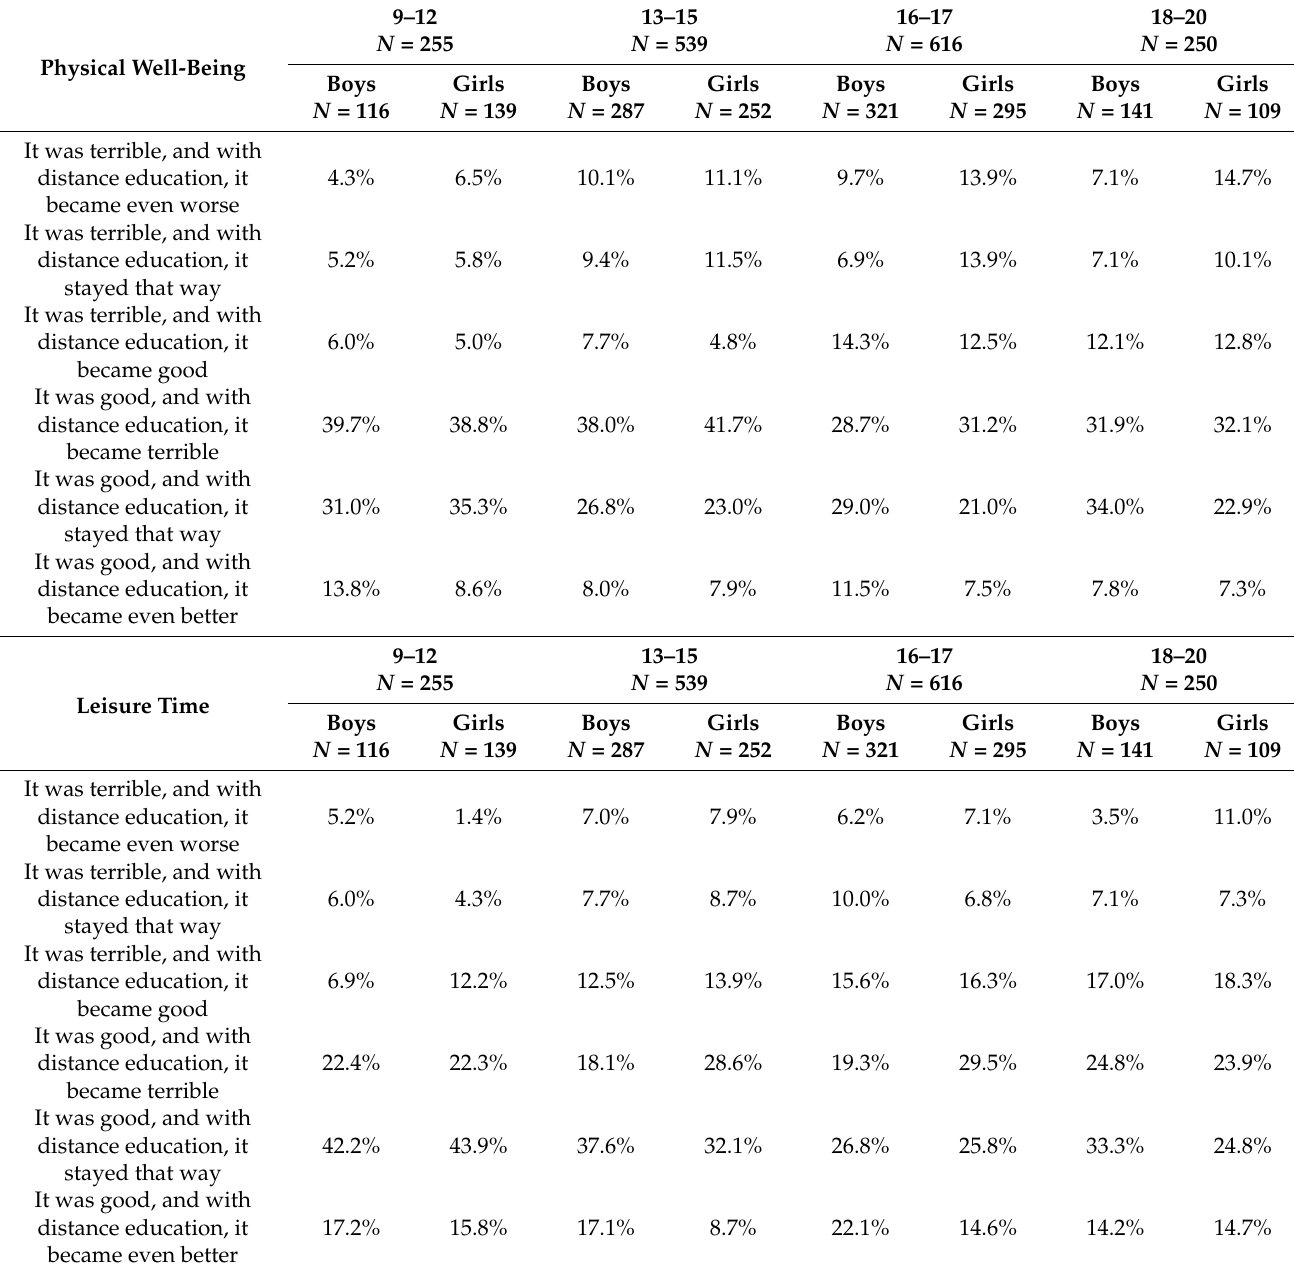
Table 3. Dependent results of the study in subgroups by age and by